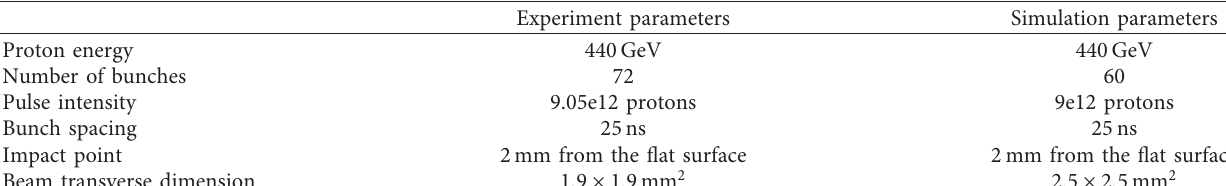
Table 4: Beam parameters, high-intensity tests on Inermet ® 180.